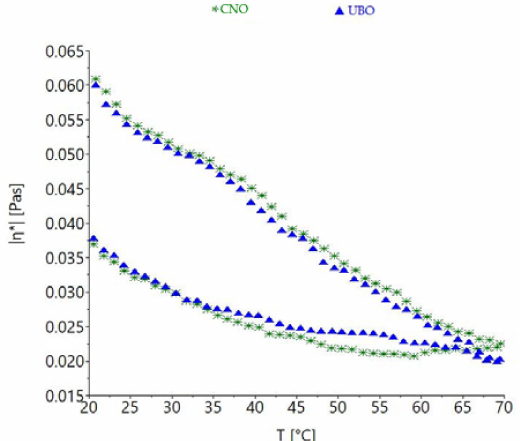
Figure 10. Variation of apparent viscosity ( η *) with temperature: UBO— U. barbata extract in canola oil; CNO—canola oil.